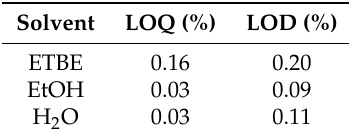
Table 1. LOD and LOQ for investigated organic